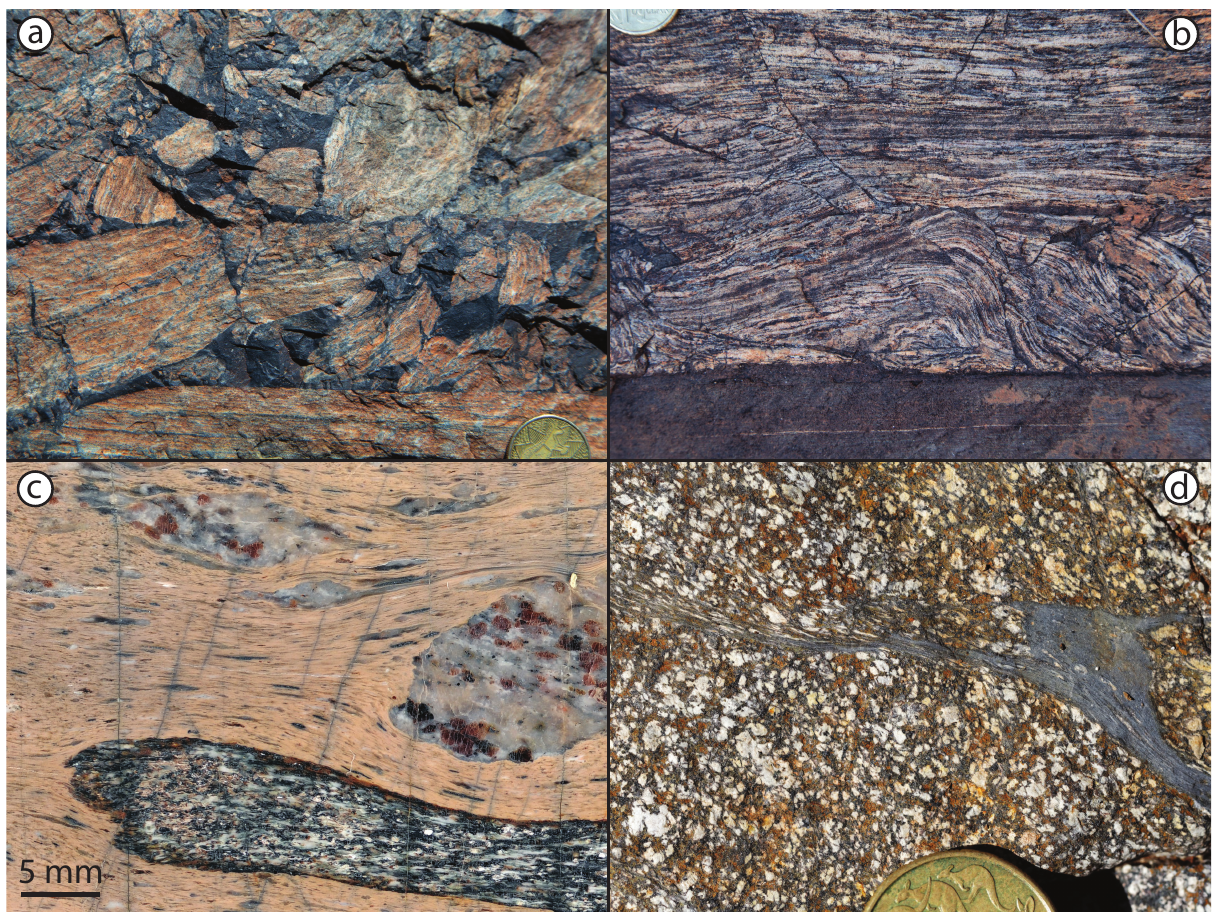
Figure 3. Field examples of pseudotachylytes: (a) pseudotachylyte breccia disrupting mylonitic foliation. Note the relative rotation of clasts, their generally angular shape and the wide range of clast sizes. (26.3877S, 131.7091E). (b) Late-stage pseudotachylyte localizing at the boundary of a sheared dolerite dyke (bottom part of the image), creating a duplex-like structure with all planes of movement decorated by pseudotachylyte (N is up, 26.3408S, 131.5255E). (c) Polished slab with caramel-coloured pseudotachylyte including fragments of quartzo- feldspathic gneiss and mafic granulite. Note the internal foliation and elongation of clasts. Note also that although the clasts are variably foliated, they are not ultramylonitic and have irregular shapes and a very wide range of sizes, typical of a cataclastic breccia (26.3853S, 131.7105E). (d) Sheared pseudotachylyte in an otherwise almost undeformed gabbro (N is up, 26.3528S,